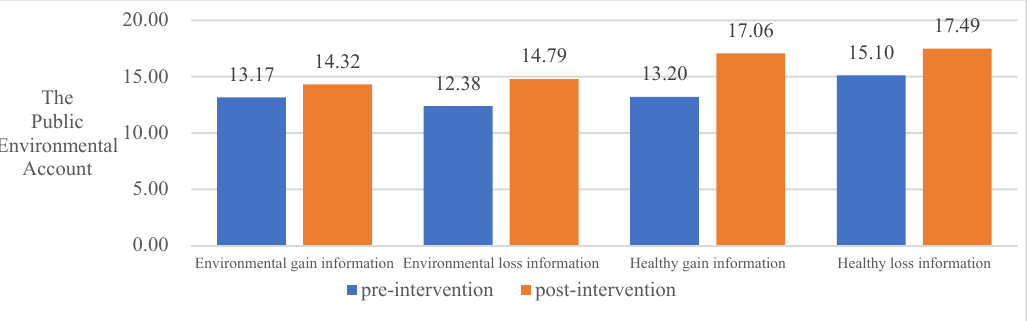
Figure 5 . The impact of different information frameworks on the Public Environmental Account.